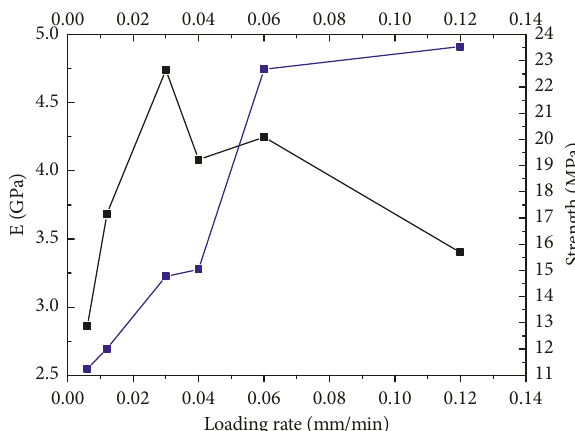
Figure 5: Statistics of elastic modulus and peak